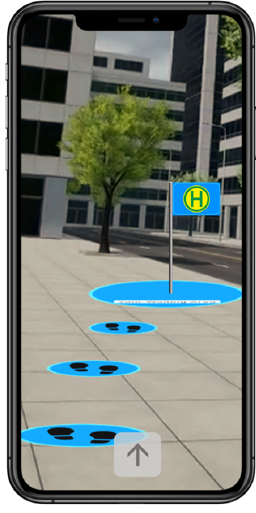
Figure 2. Exemplary arrangement of information elements in vStop HMI prototype.